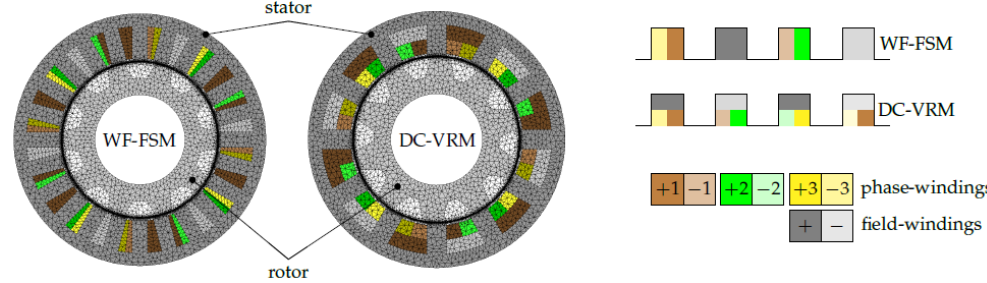
Figure 2. Three-phase WF-FMM ( left ) models in static 2D-FEM; Phase/DC slots: ( left ) 24/24 wound-field flux switching machine (WF-FSM), 12/24 DC-excited vernier reluctance machine (DC-VRM) and ( right ) winding